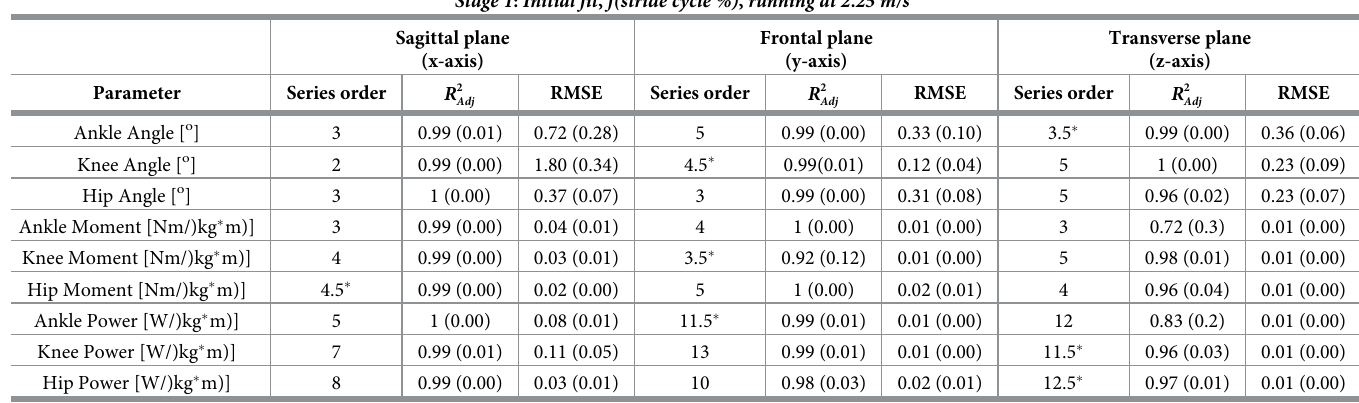
Table 1. Evaluation of the prediction equations for each lower-limb joint variable for each given surface gradient as a function of stride-cycle percentage (Stage 1) in all anatomical planes when running at 2.25 m/s. The adjusted R 2 and RMSE values are presented as averages across surface gradients and standard deviation (in brackets).